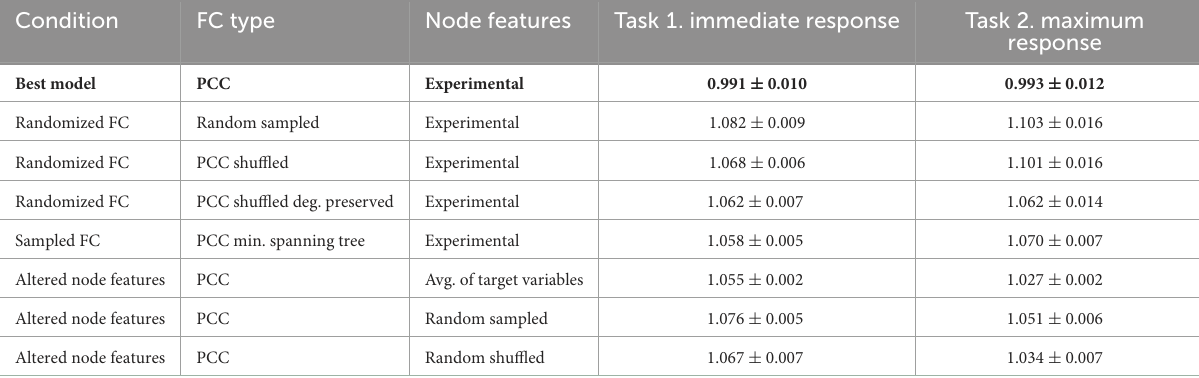
TABLE 2 Ablation study (average